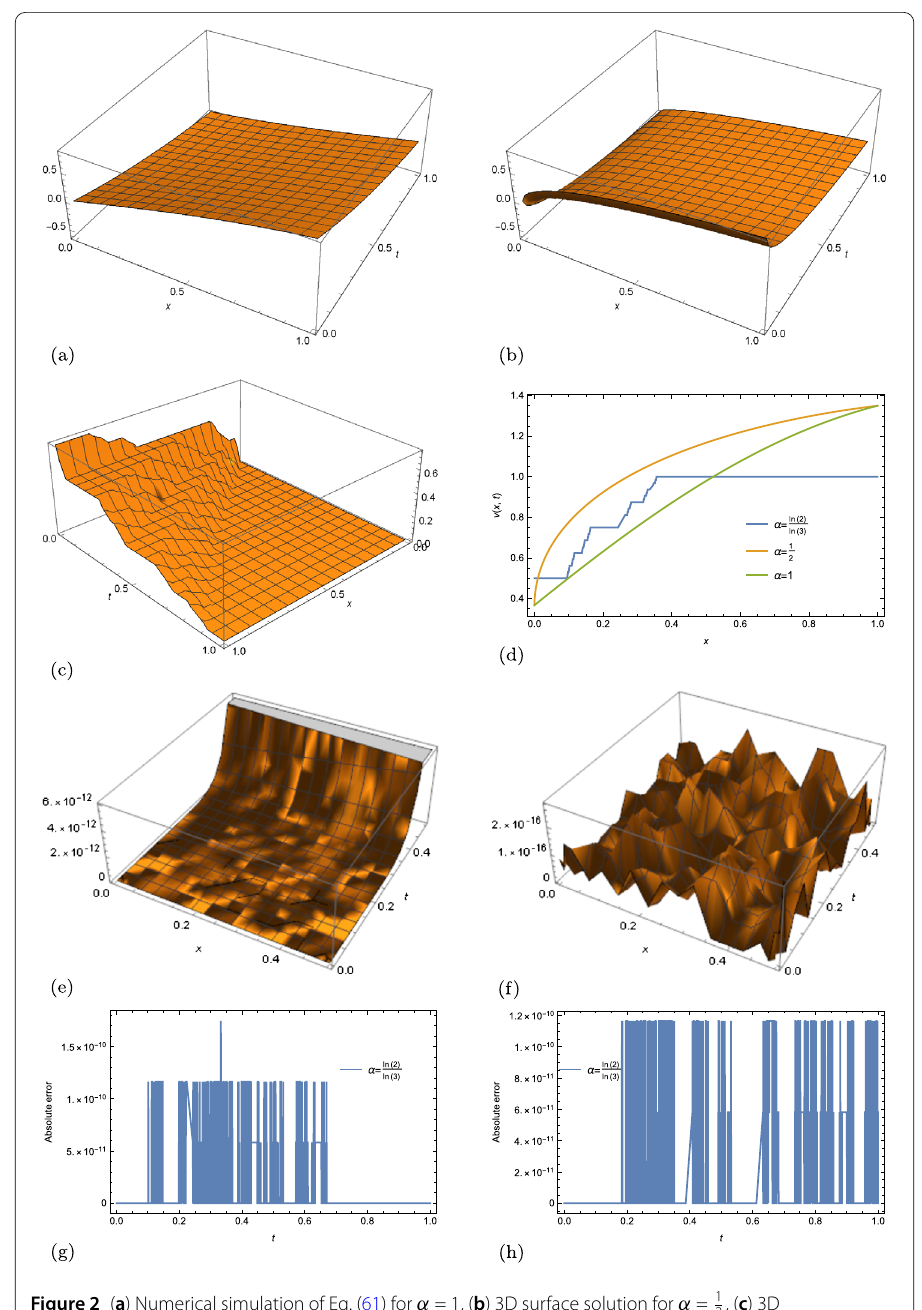
Figure 2 ( a ) Numerical simulation of Eq. (61) for α = 1, ( b ) 3D surface solution for α = 1 non-differentiable surface solution behavior for α = ln(2) ( e ) Absolute error E 10 ( v ( x , t )) = | v ext . ( x , t ) – v appr . ( x , t ) | , α = 1, ( f ) Absolute error E 20 ( v ( x , t )) = | v ext . ( x , t ) – v appr . ( x , t ) | ( g ) Absolute error of the LFHAM E 10 ( v ( x , t )) = | v ext . ( x , t ) – v appr . ( x , t ) | for α = ln(2) LFHAM E 20 ( v ( x , t )) = | v ext . ( x , t ) – v appr . ( x , t ) | for α = ln(2)